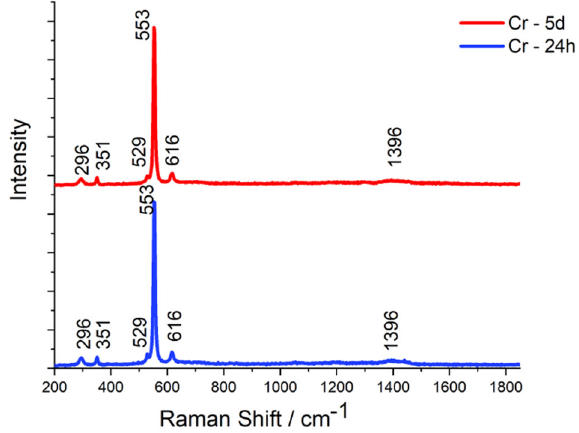
Fig. 3 Raman spectra of chromium samples oxidized at 700 °C in air for 24 h (lower, blue spectrum) and 5 days (upper, red spectrum). Both spectra were analyzed for evidence of Cr 2 O 3 Raman peaks.